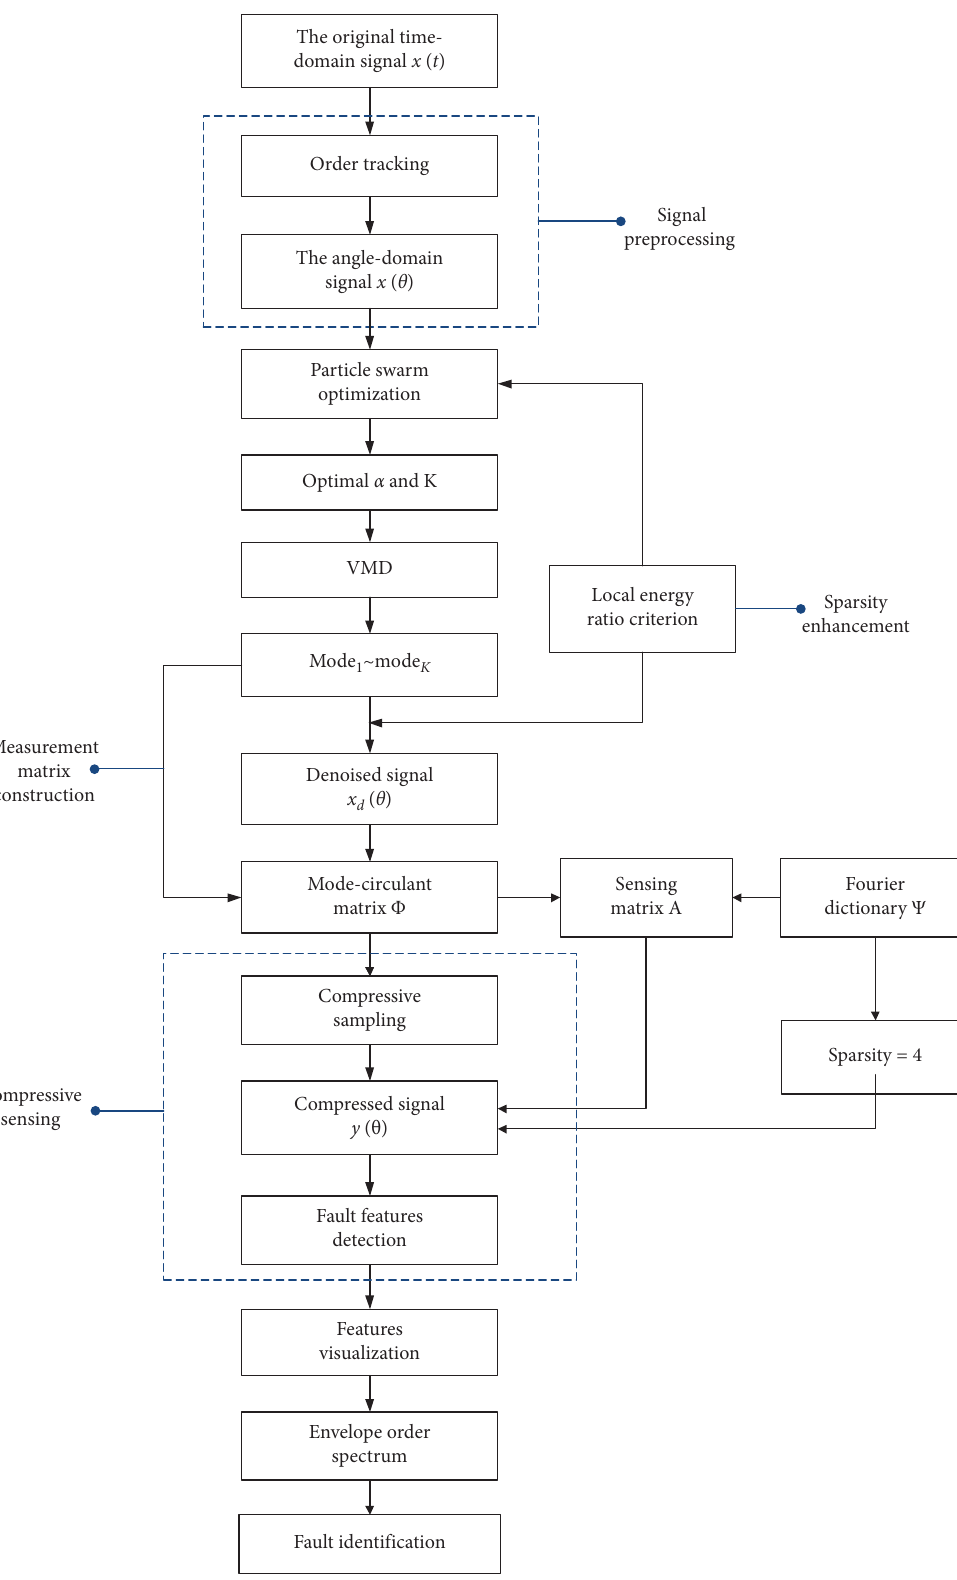
Figure 1: Schematic of the proposed bearing weak fault feature extraction